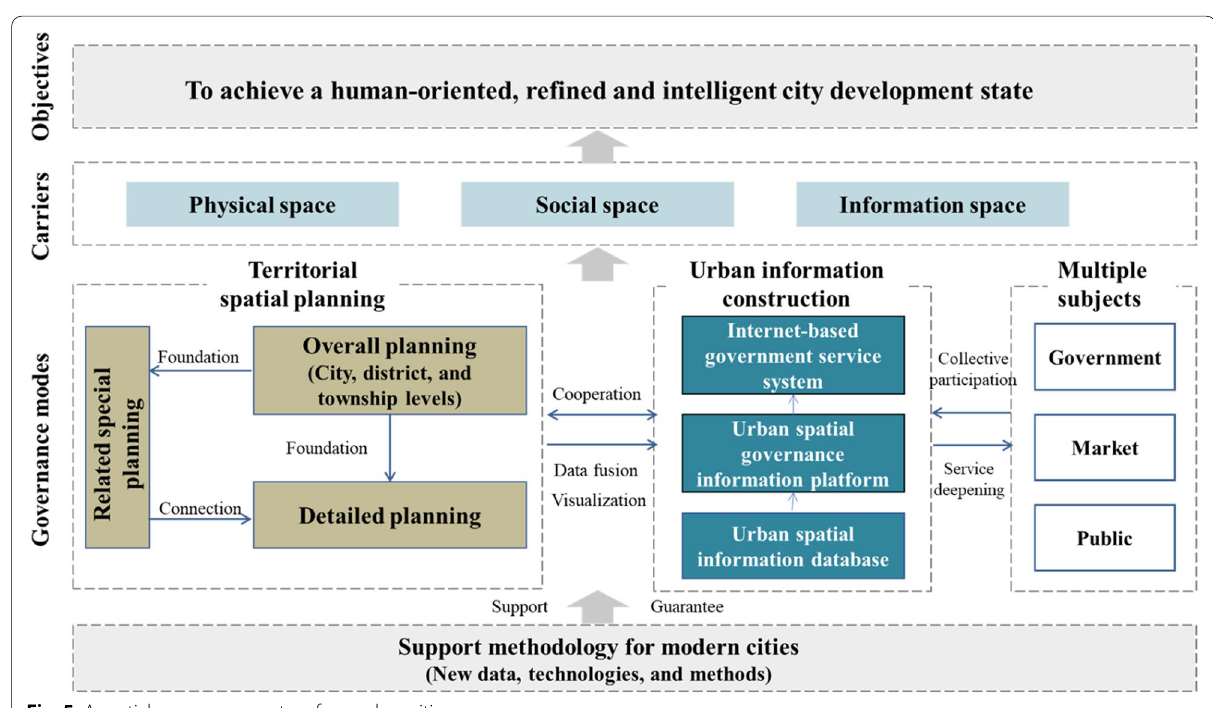
Fig. 5 A spatial governance system for modern